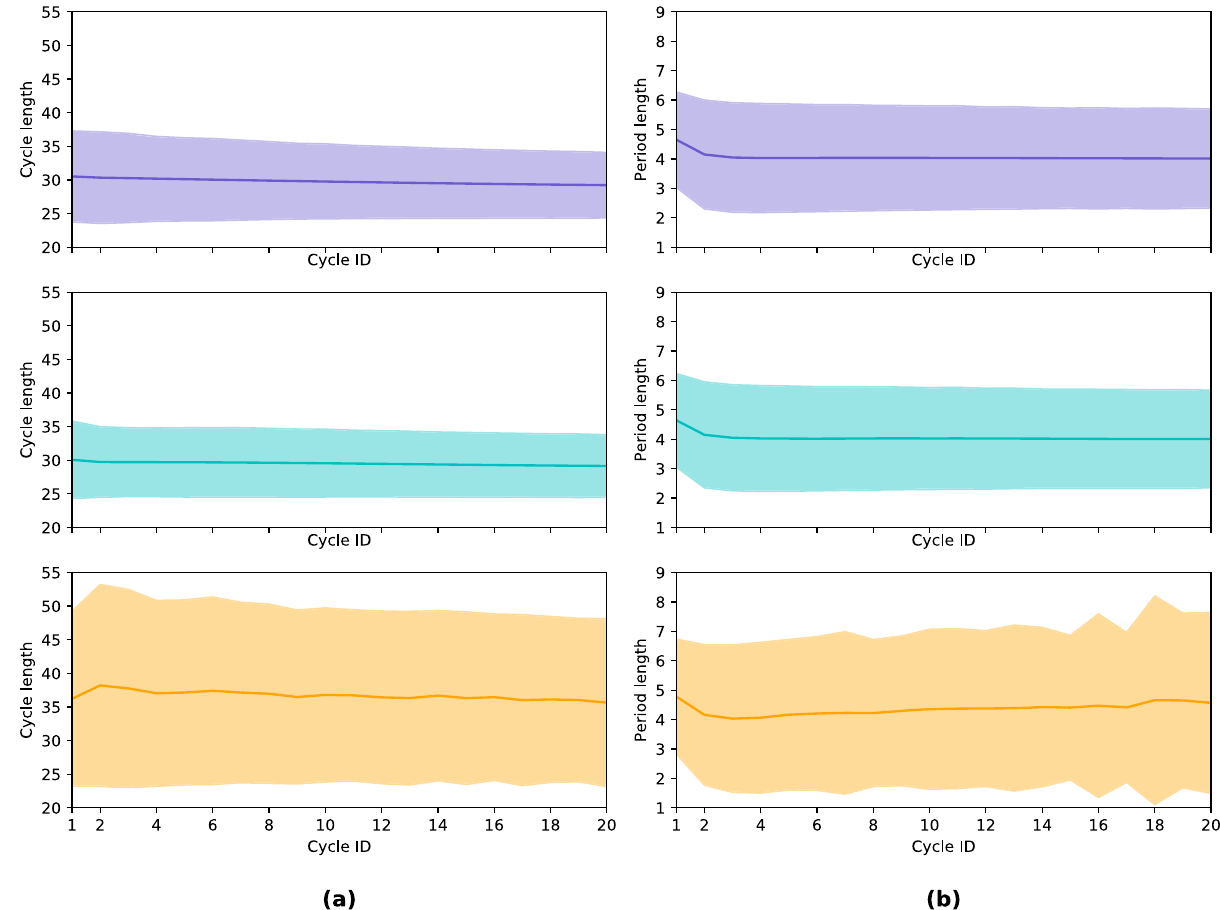
Fig. 5 Average cycle and period length by cycle ID. For each user ’ s cycles (indexed by cycle ID), we average cycle ( a ) and period length ( b ) across three different groups: the entire user cohort (top, purple), the consistently not highly variable user cohort (middle, teal), and the consistently highly variable user cohort (bottom, orange). This allows us to visualize how cycle and period length vary over time for each group on average and in terms of standard deviation (for illustrative purposes, we restrict the cycle ID to 20). Cycle and period length statistics are stationary over the app usage timeline within each plot. We note that the top and middle plots look similar in each fi gure (i.e., the consistently not highly variable group looks similar to the overall population in terms of both cycle and period length), but the wider shaded orange spread of the bottom plot demonstrates the higher degree of variability in the consistently highly variable group. In addition, this spread is consistently wider for the orange plot over time. This showcases that the consistently highly variable group represents a large degree of the variability that we see in the data